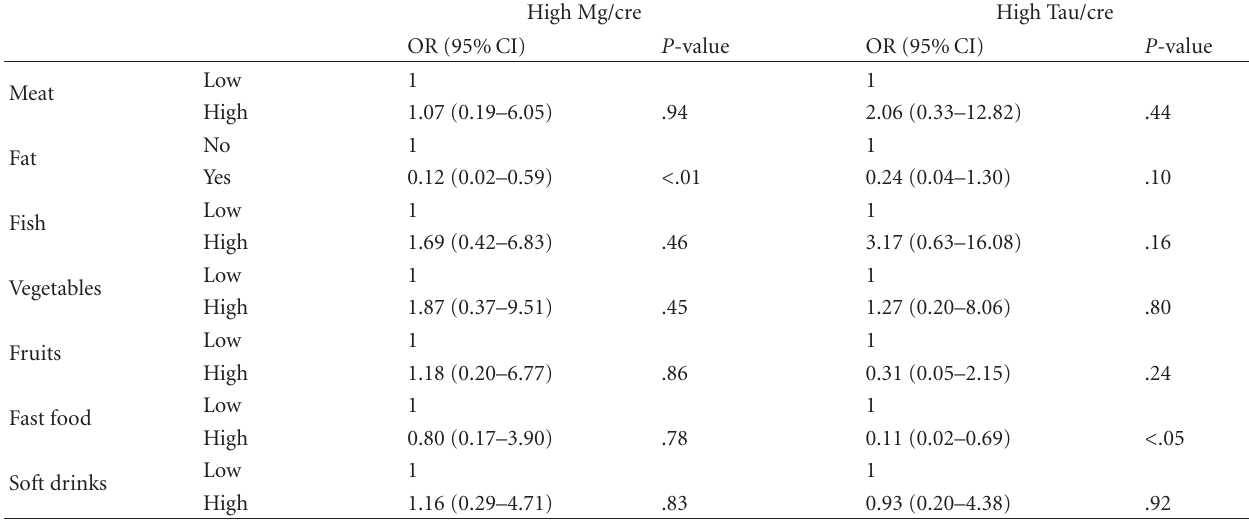
Table 5: Adjusted odds ratios of urine Mg/cre and Tau/cre according to eating